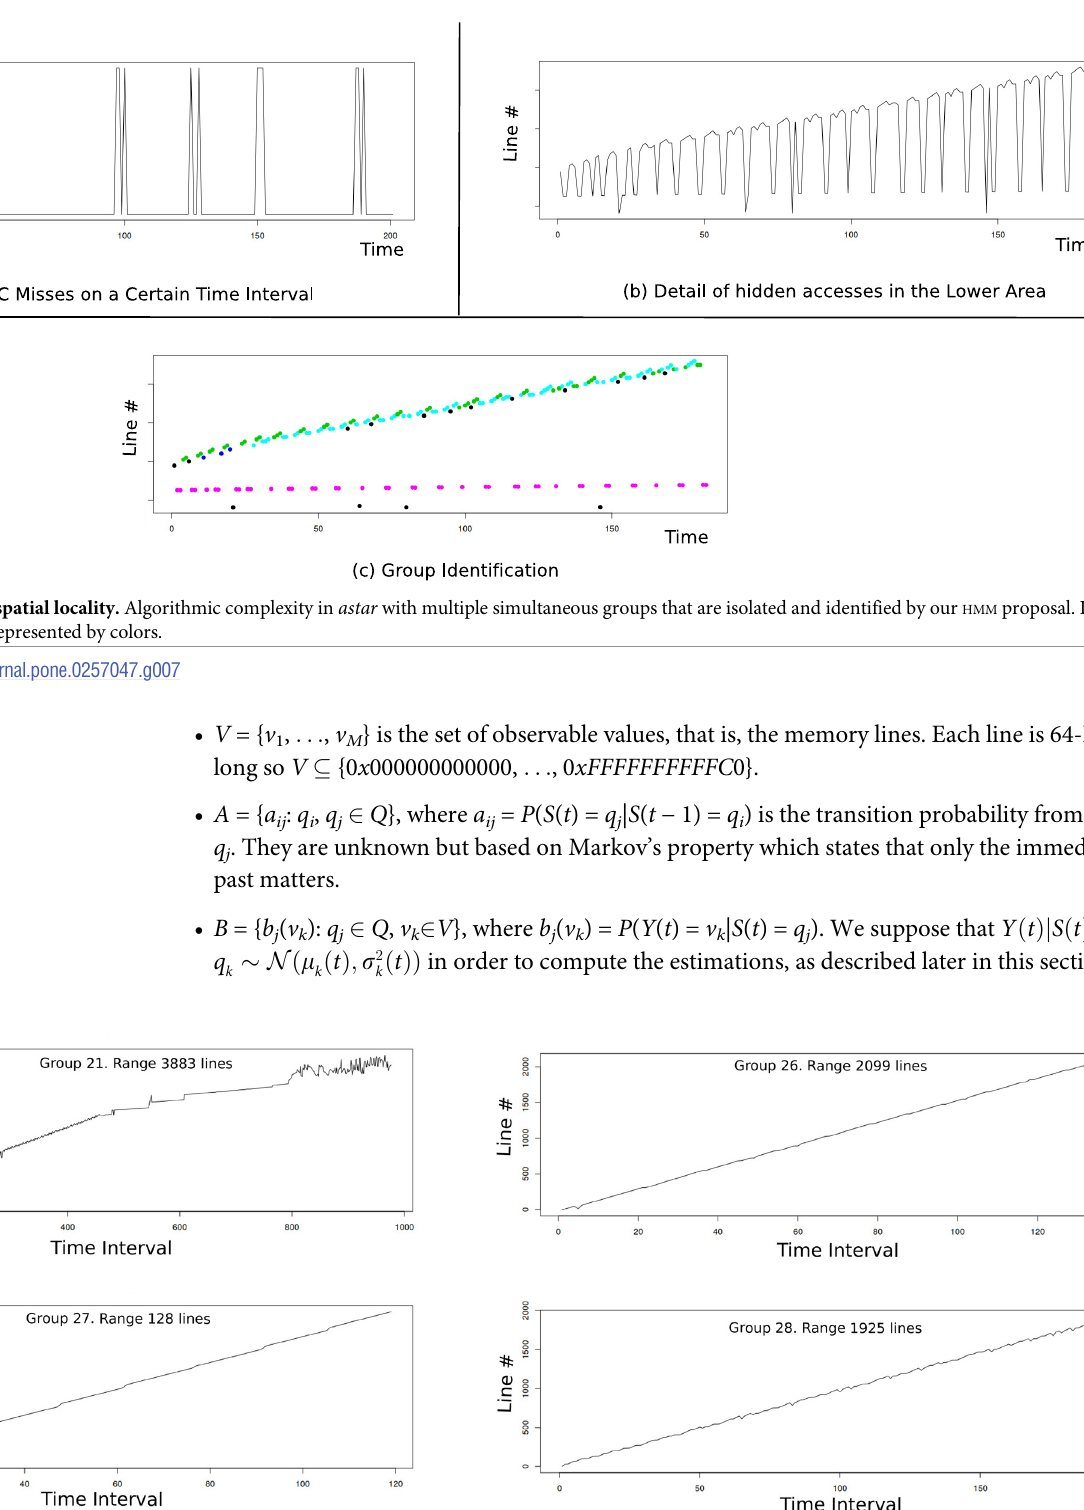
Fig 8. Main areas of spatial locality in astar . Example of four groups identified in astar by HMM . This information is feeded to the prefetcher to get intervals of addresses with high probability of future use.